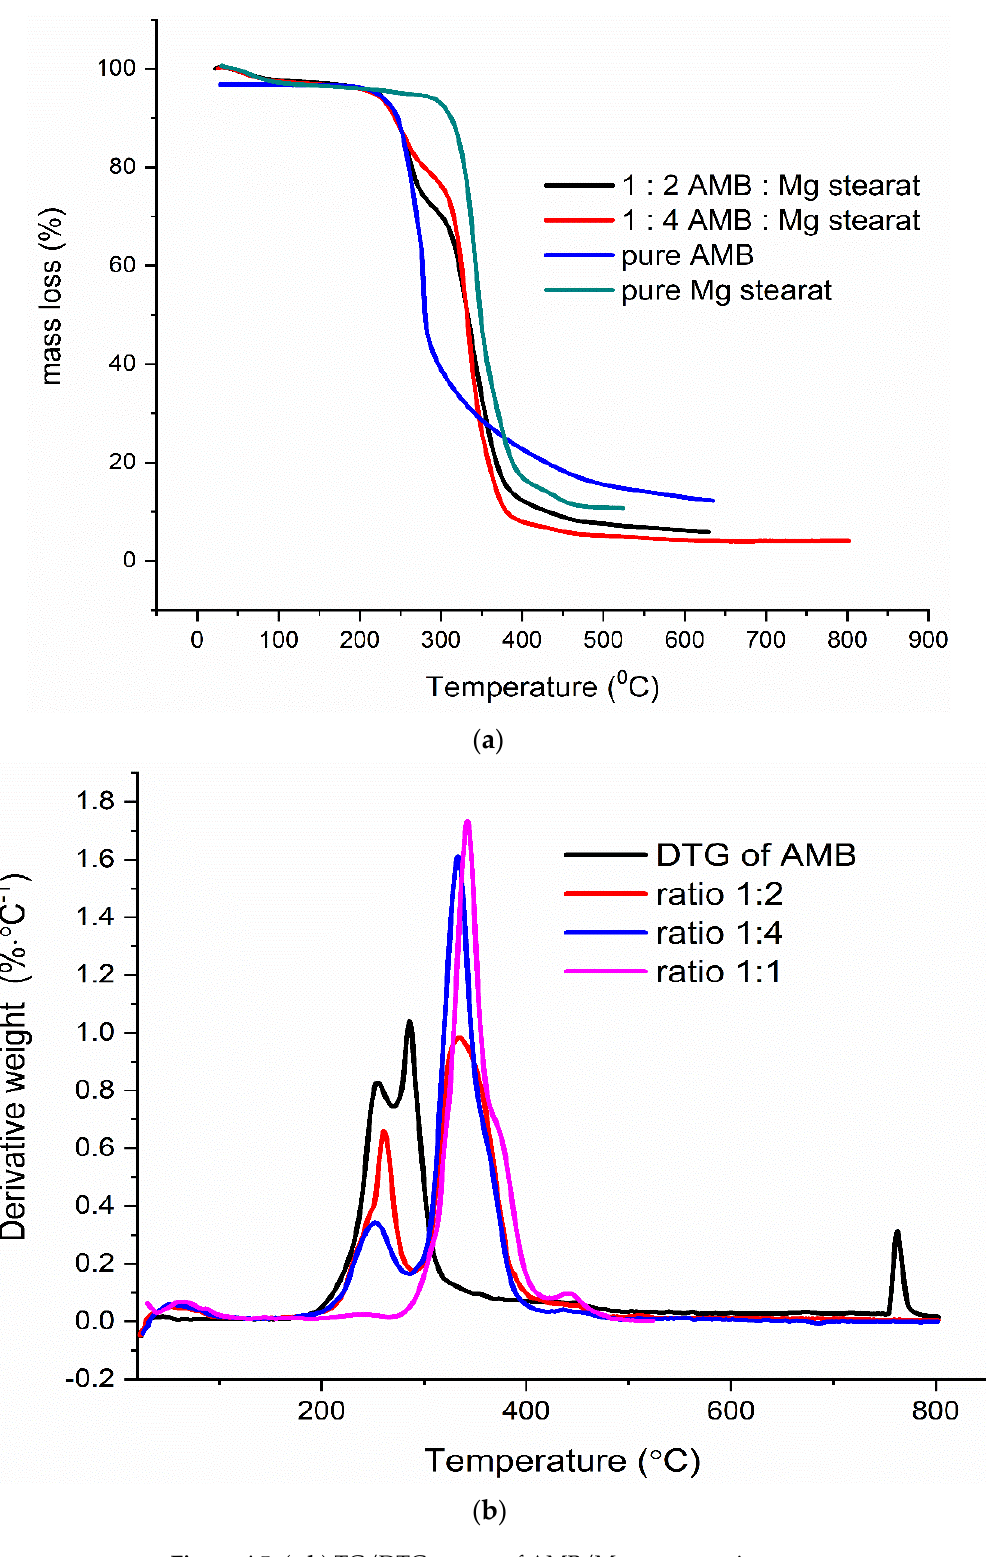
Figure A5. ( a,b ) TG/DTG curves of AMB/Mg stearate mixtures. Figure A5. ( a , b ) TG/DTG curves of AMB/Mg stearate